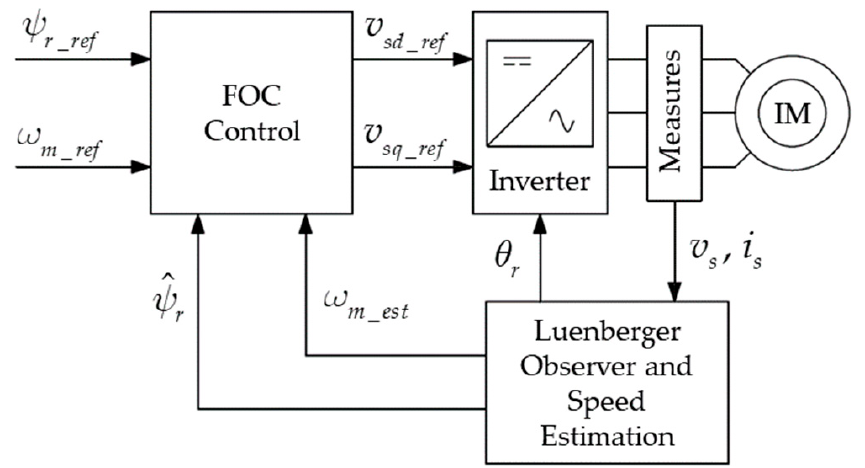
Figure 1. FOC block diagram implementation.